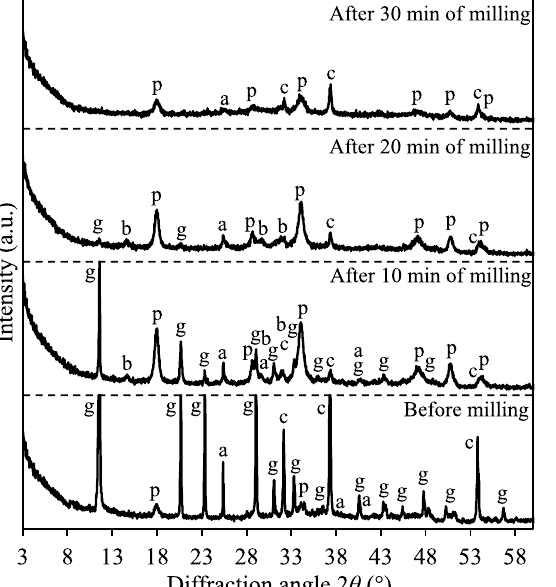
Figure 1. XRD patterns of the initial mixture at the different stages of mechanochemical treatment. The X-rays with a wavelength of 1.5406 Å (CuKα radiation) were used. Indexes: g – gypsum, p – portlandite, c – calcium oxide, a – anhydrite, b – bassanite.